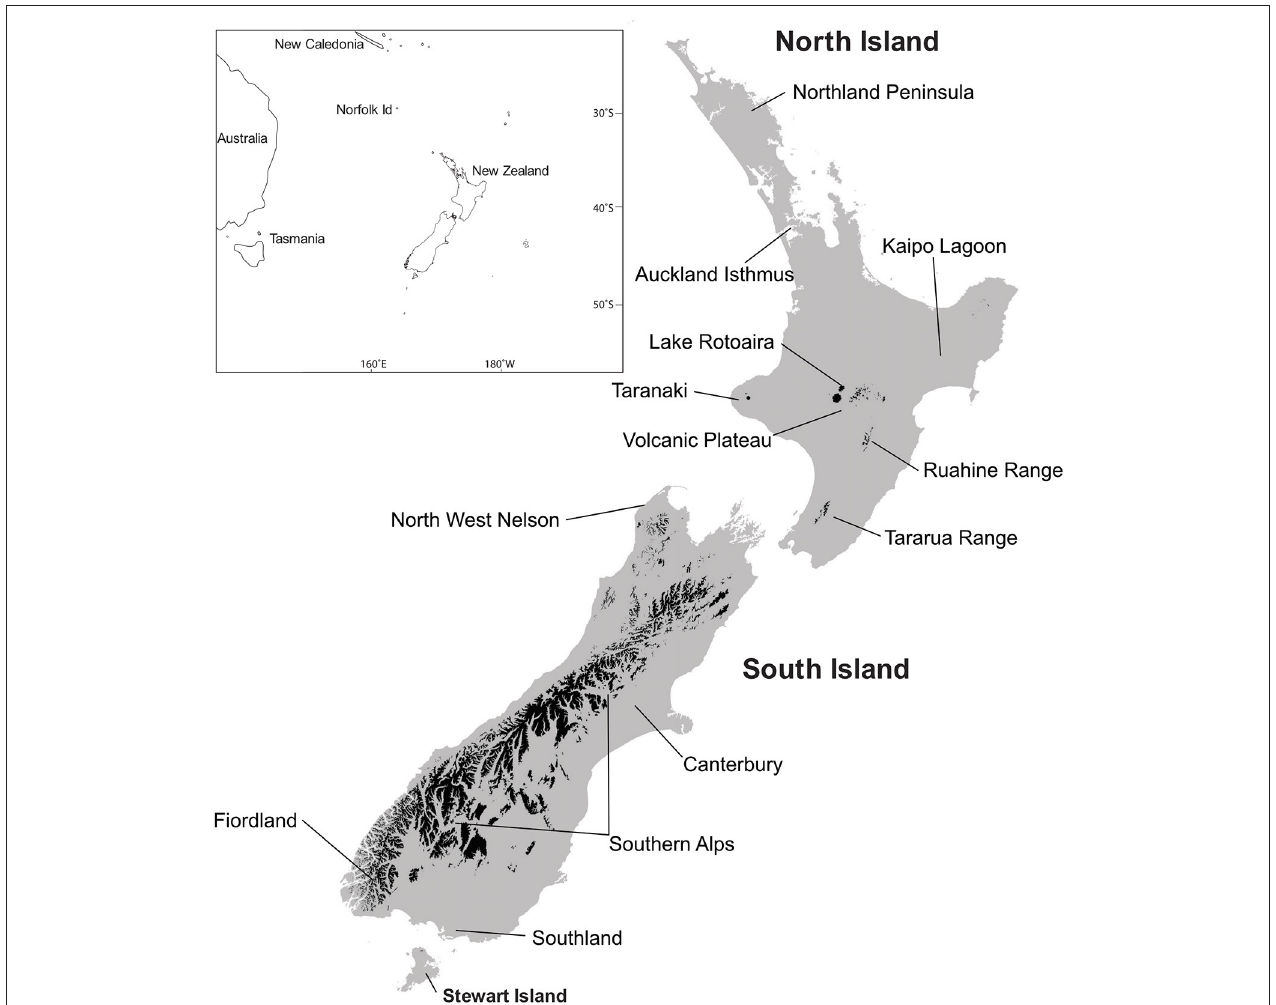
FIGURE 2 | Localities mentioned in the text. Areas in black, above tree line. Baseline data, Landcare